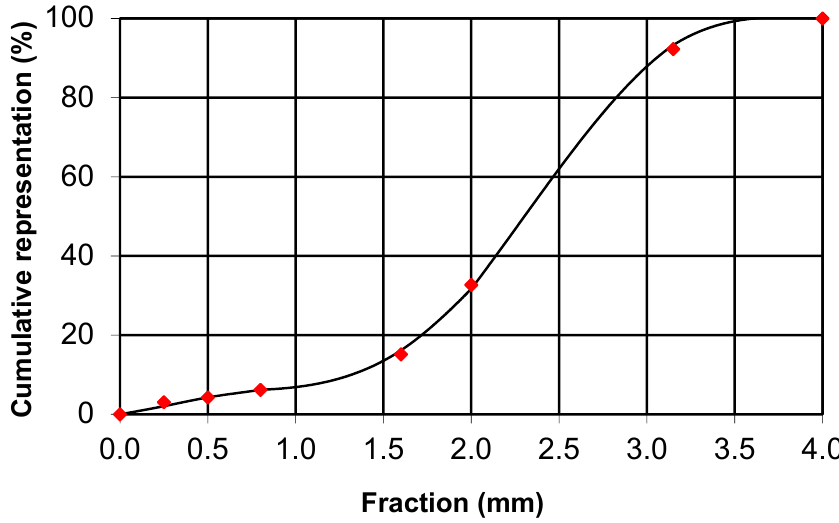
Figure 4. Fraction of winter wheat husk.